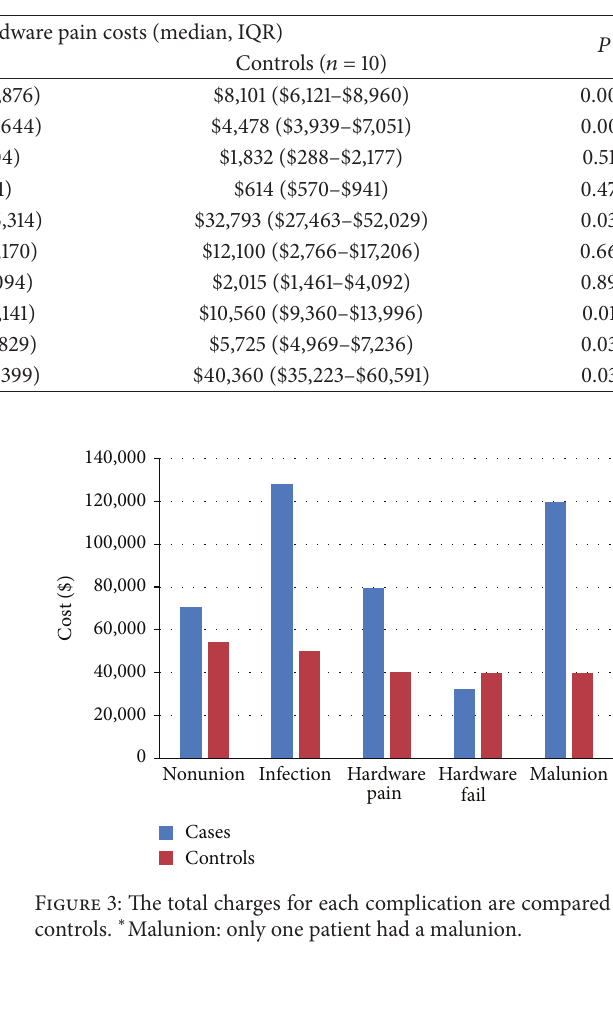
Table 5: Case versus control comparison for hardware pain costs.